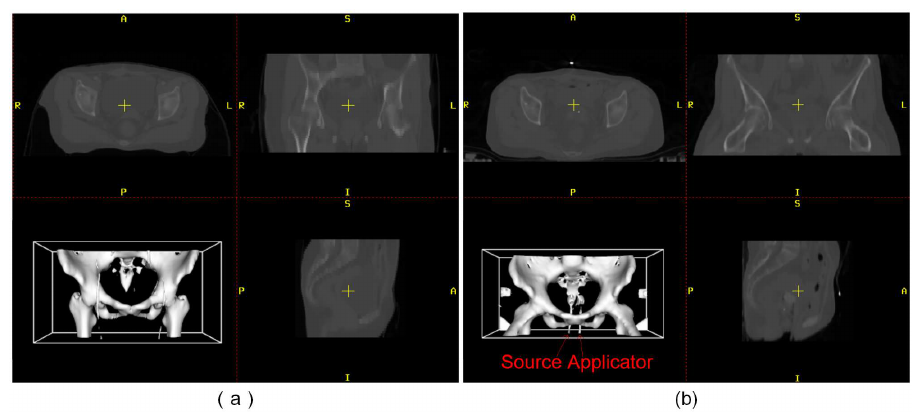
Fig 7. Original clinical data of one cervicalcancer patient. (a) EBRT CT image. (b) HDR-BT CT image.